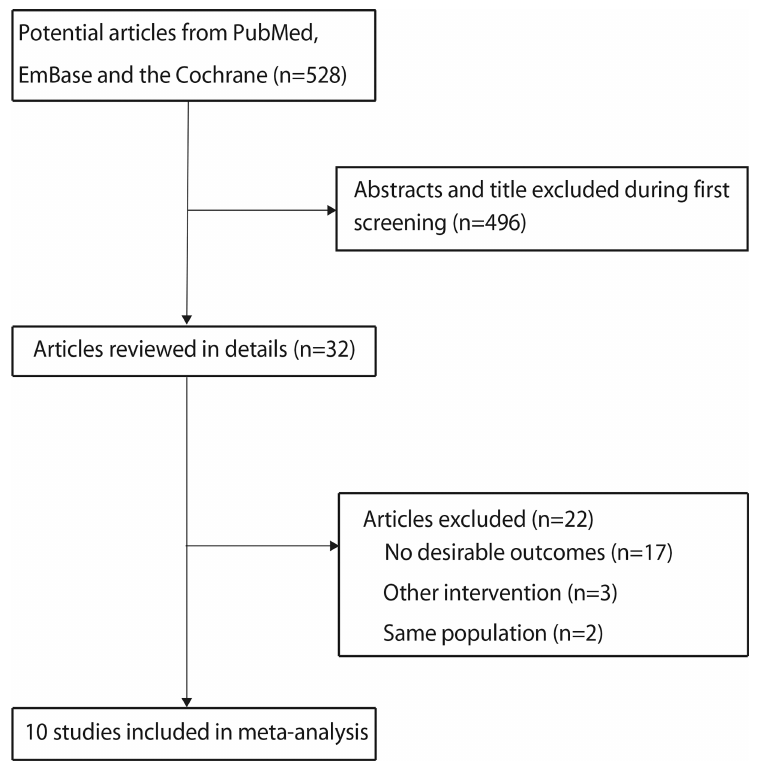
Fig 1. Flow diagram of the literature search and selection